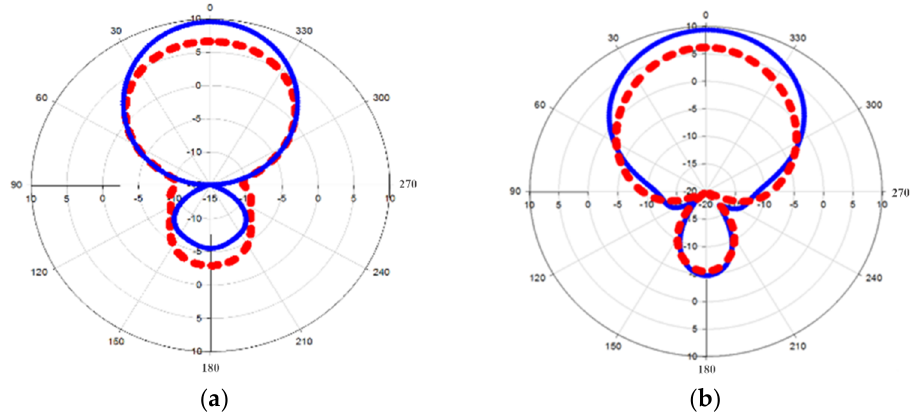
Figure 9. Azimuth plane of polar radiation pattern in: blue (measured) and red (simulated), ( a ) 2 GHz and ( b ) 3 GHz.